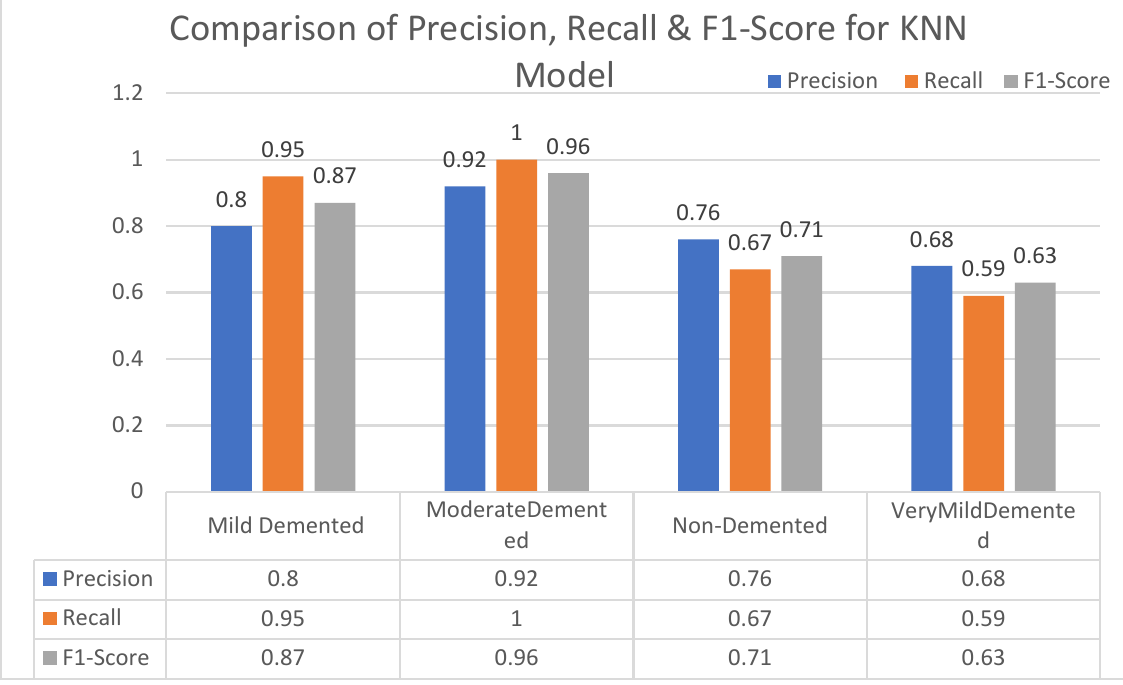
Figure 12. Visualization of Diagnostic Test for KNN Model.